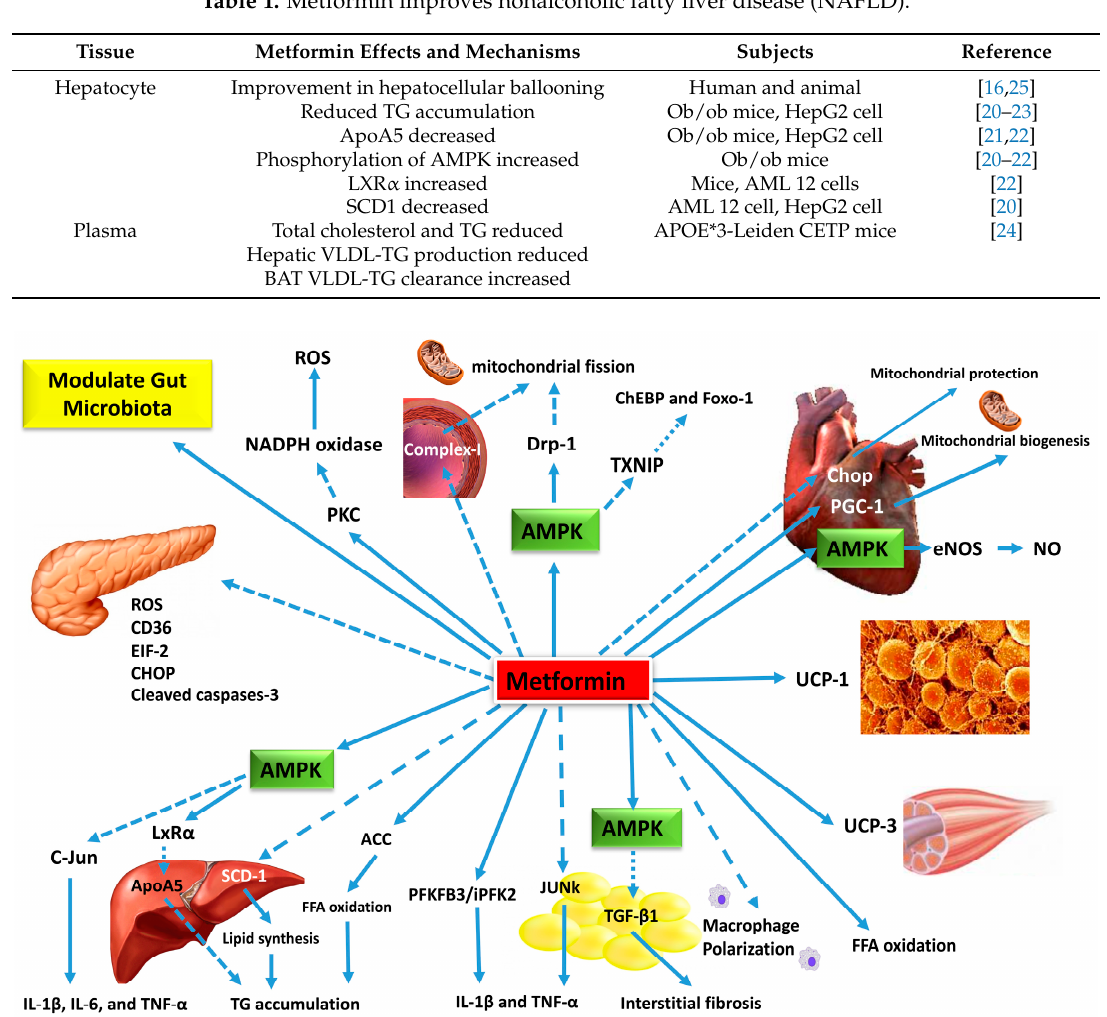
Potential underlying molecular mechanisms of action of metformin on NAFLD, atherosclerosis, oxidative stress, and pancreatic β -cell dysfunction (dotted arrows: inhibition, solid arrow: activation).